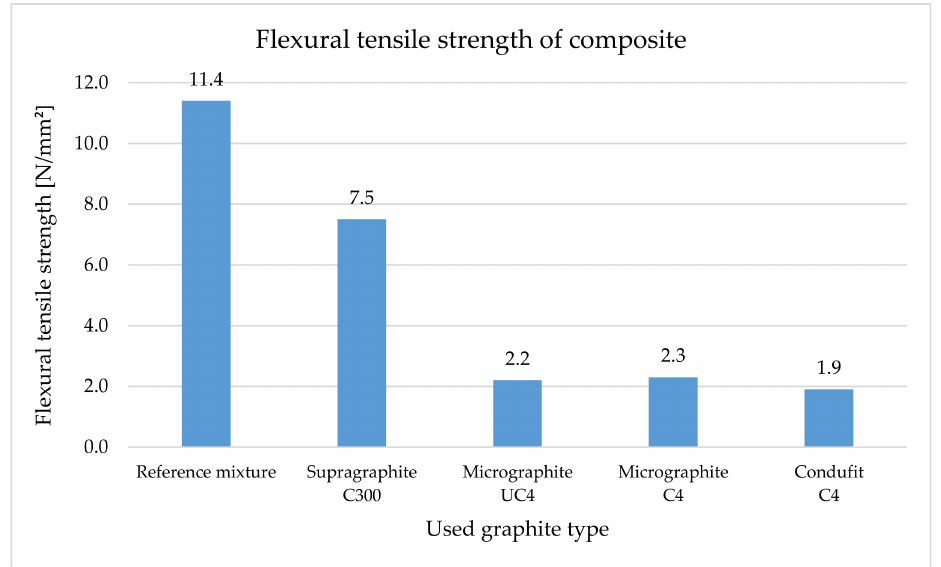
Figure 14. Flexural tensile strength of the composite. The effect of fine graphite on the compressive strength is more notable (Figure 15), where they decreased the compressive strength by approximately 90%. The addition of a coarse type of graphite caused a lower decrease, by 58%.